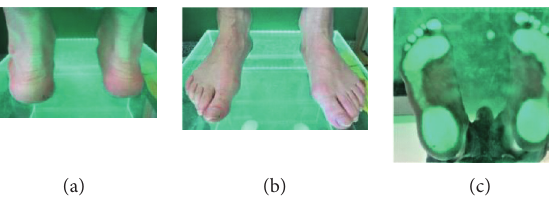
Figure 4: (a–c) Podoscopic tests: patient no. 5. (a) Posterior picture: ankle joint and hindfoot evaluation. (b) Anterior picture of the feet: assessment of toe positioning and deformation. (c) Plantar photo on the podoscope: assessment of plantar part of the foot and height measurement of the longitudinal arch.